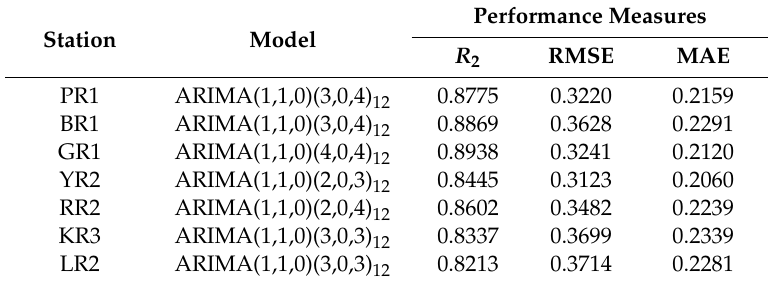
Table 5. Performance measures for the selected model for the observed data and predicted values. Station Model